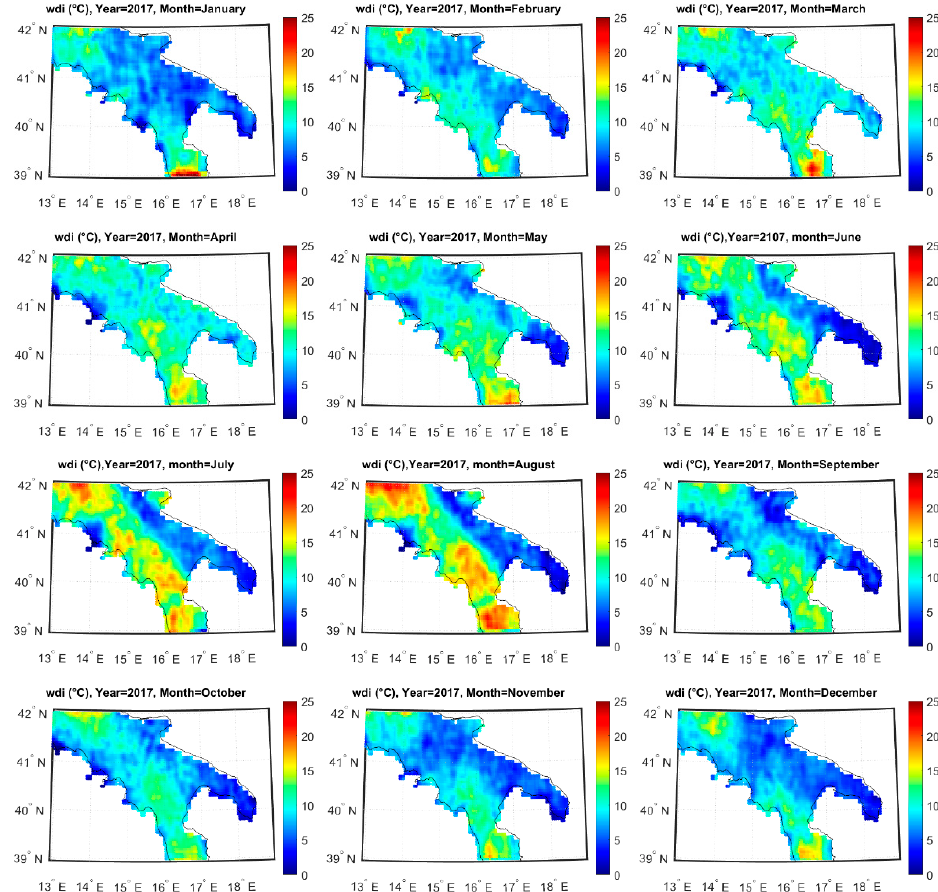
Figure 6. Level 3 map at a grid step of 0.05 degrees for the index 𝑤𝑑𝑖 for 2017.